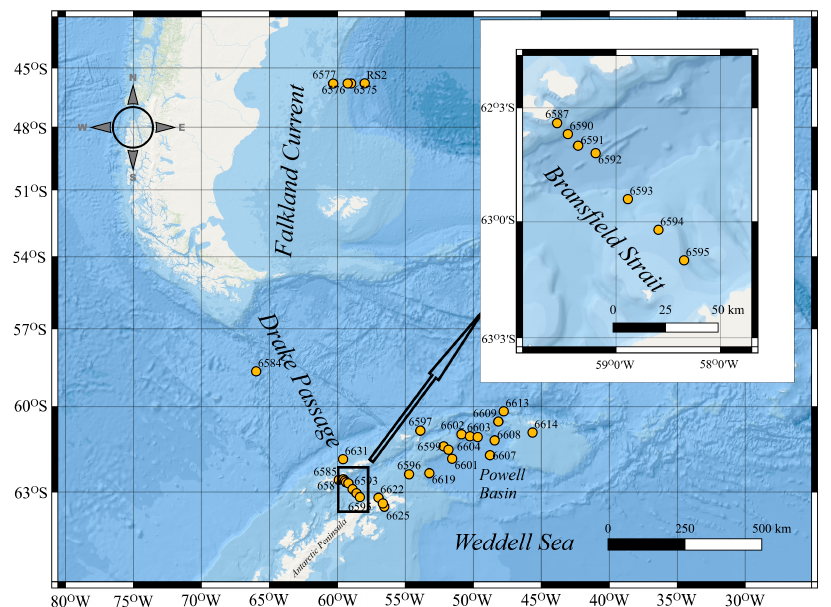
Figure 4. The map-scheme of sampling for scientific research of the spectral bio-optical properties and productive characteristics of phytoplankton.